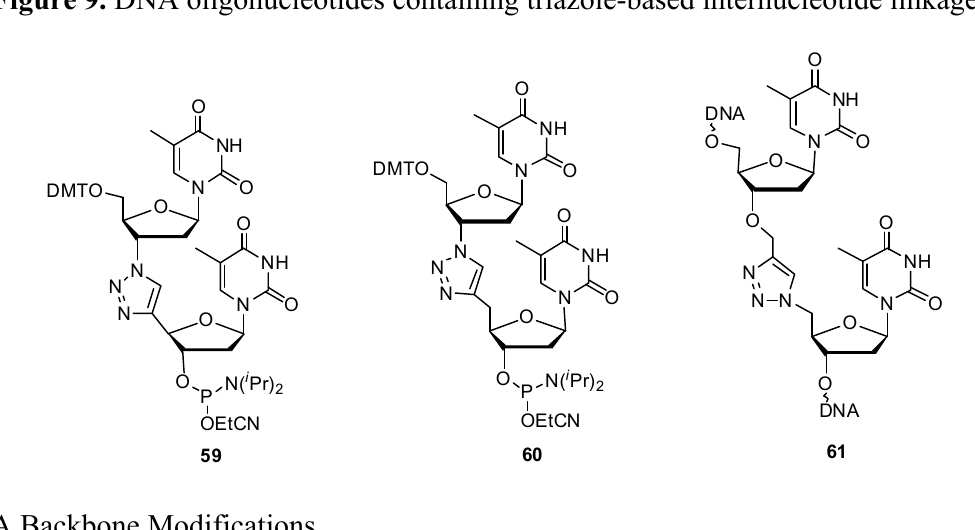
Figure 9. DNA oligonucleotides containing triazole-based internucleotide